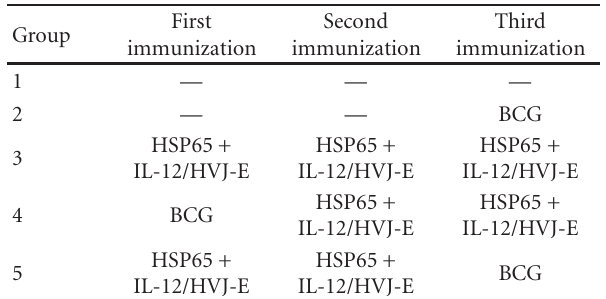
Table 1: BCG-HVJ-E/HSP65 DNA + IL-12 DNA Prime/Boost Experiment. Groups of mice were vaccinated 2 or 3 times with IgHSP65 + mIL-12/HVJ-E vaccine and/or BCG by using the prime- boost method. IgHSP65 + mIL-12/HVJ-E vaccine was injected intramuscularly, and BCG was injected subcutaneously. 4 weeks after the last immunization, M. tuberculosis H37Rv was challenged intravenously. 5 weeks and 10 weeks after TB challenge, protection was measured by enumerating bacterial loads (CFU) in the lungs, liver, and spleen from vaccinated mice. One week before the TB challenge, the immune responses of cytotoxic T cells, proliferation of T cells, and cytokines (IFN- γ , IL-2, IL-6) production were